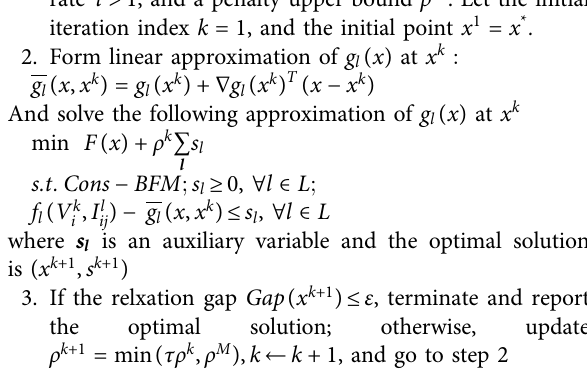
Algorithm 1: Feasibility Recovery